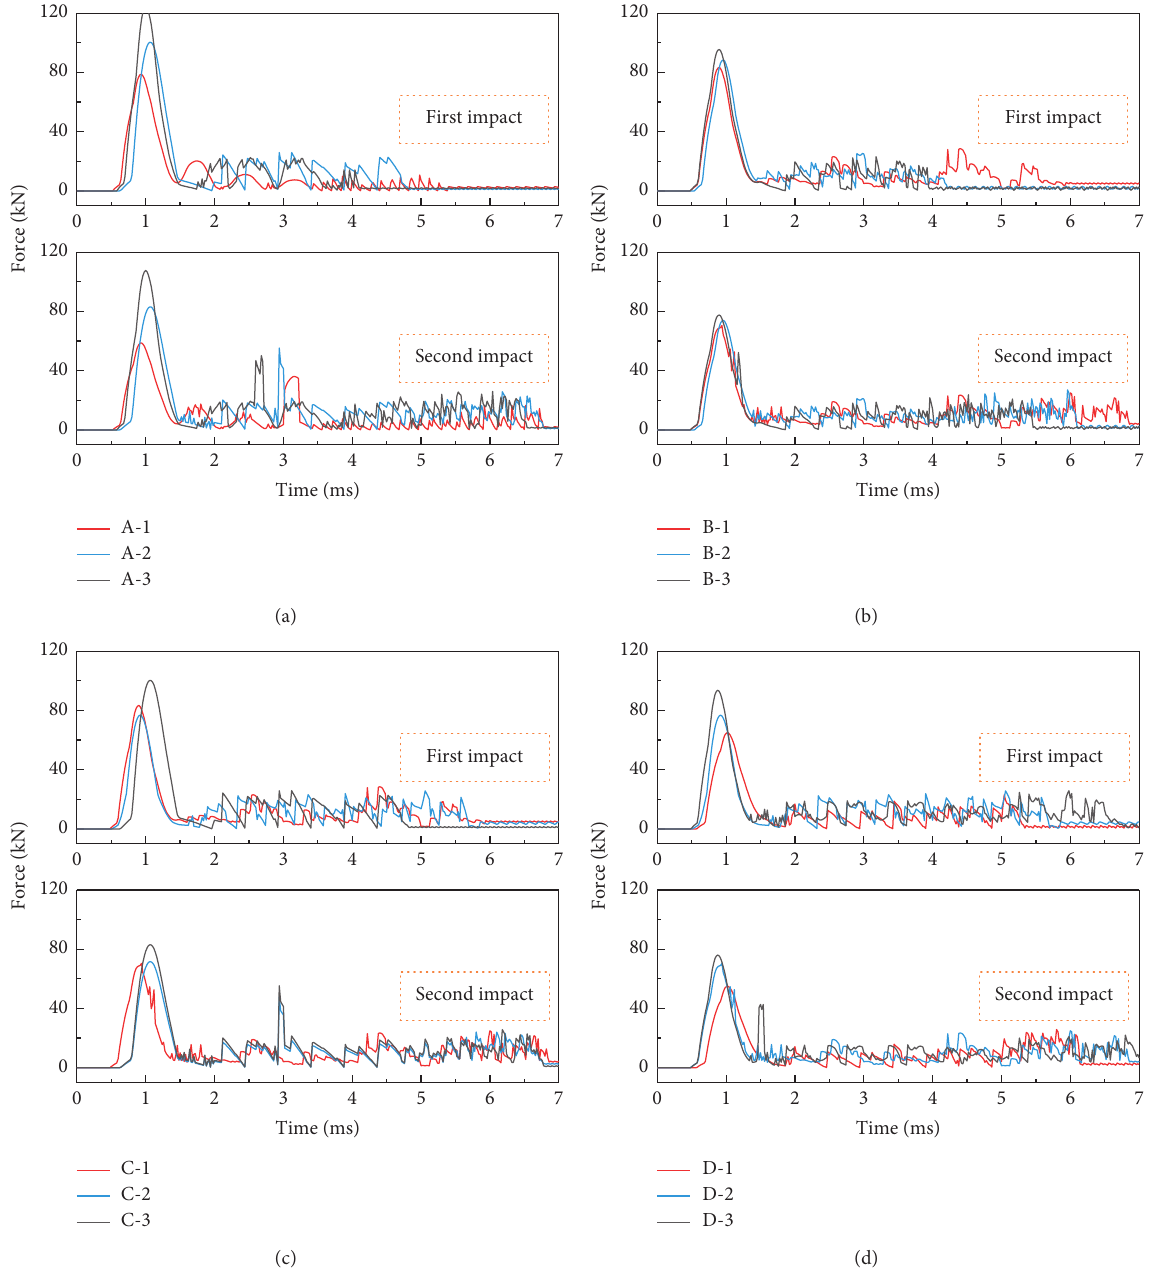
Figure 7: Time history curves of impact